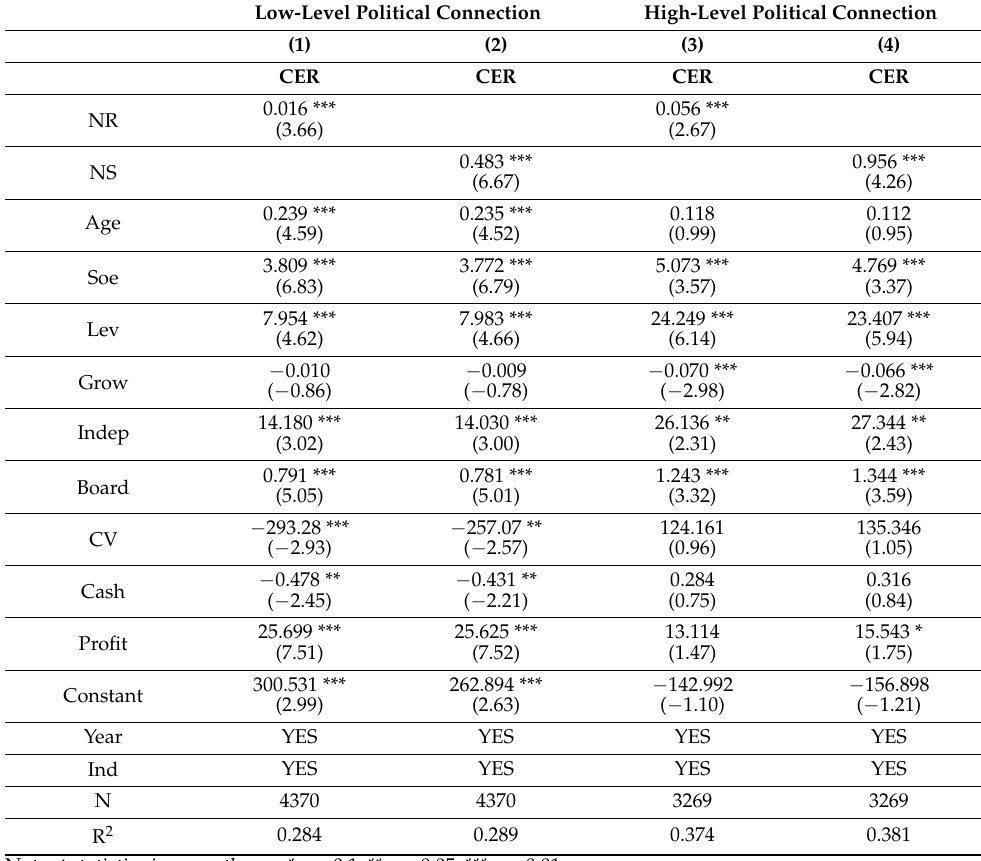
Table 10. The impact of political